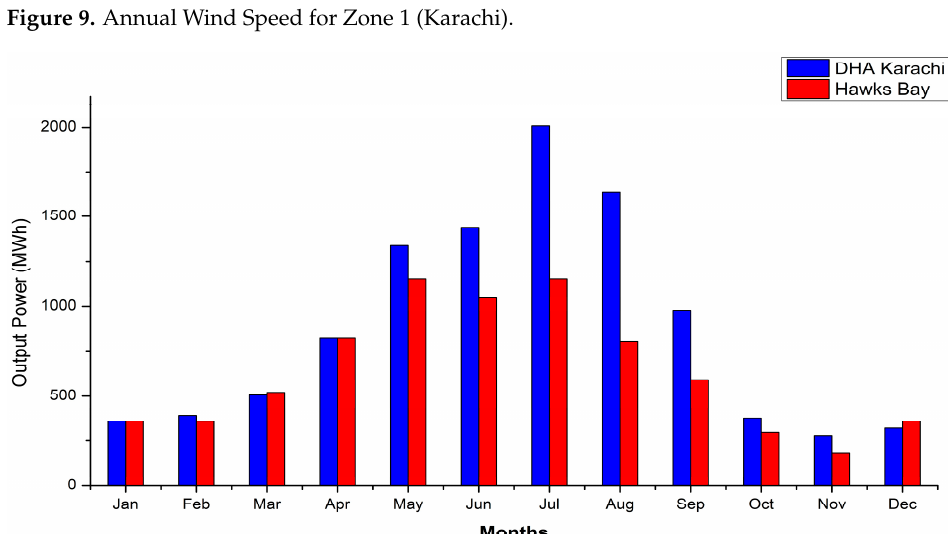
Figure 10 . Power output in MWh for Zone 1 (Karachi). (2) Zone 2—Thatta